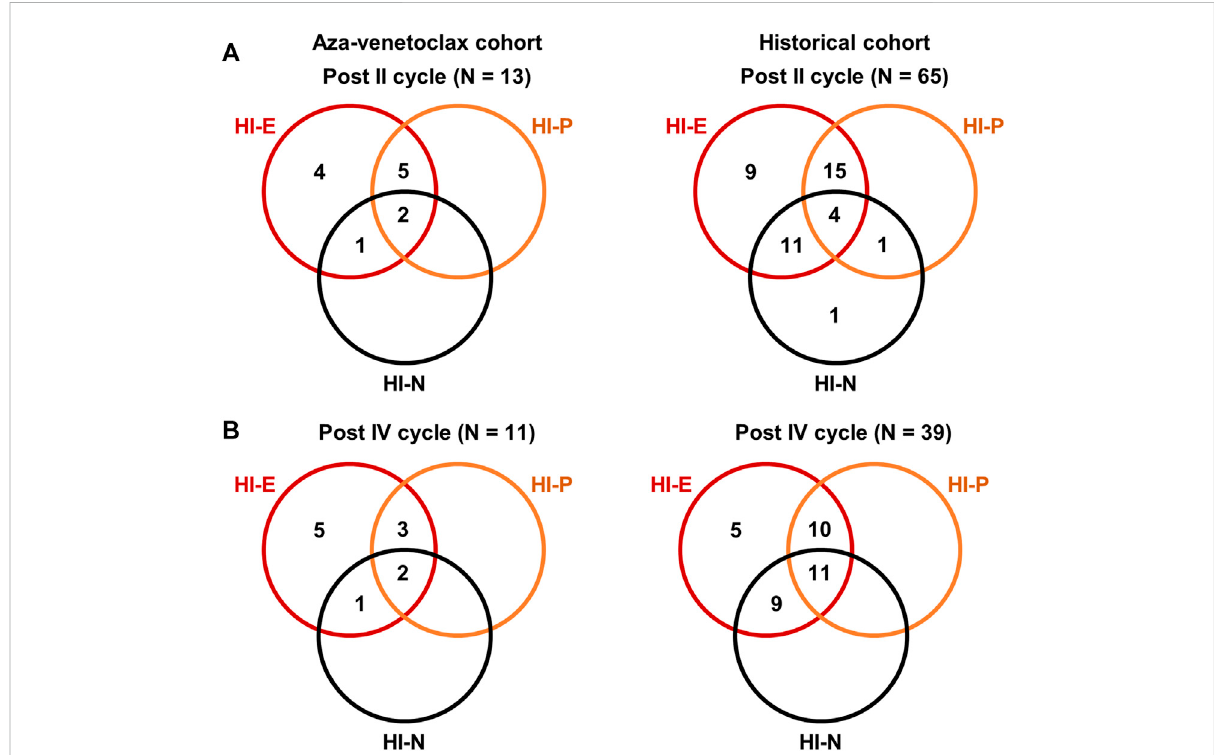
FIGURE 1 Hematologicalimprovements(HI)ofpatientstreatedwithazacytidineplusvenetoclax.HIwerereportedforerythroid(HI-E),neutrophils(HI-N), and platelet counts (HI-P) as de fi ned in international guidelines. Venn diagrams showing the number of patients with single lineage and multilineage responses to azacytidine plus venetoclax (aza-venetoclax cohort) or to azacytidine as single agent (historical cohort) after the second (A) and fourth (B) cycle of